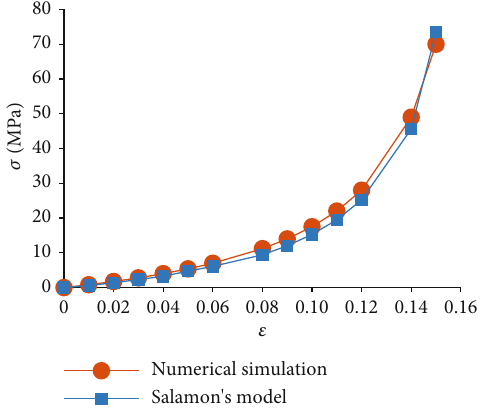
Figure 9: The stress-strain fi tting